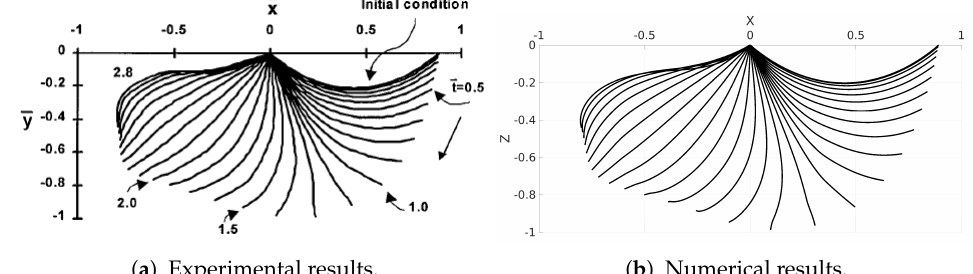
Figure 10. Results for a cable